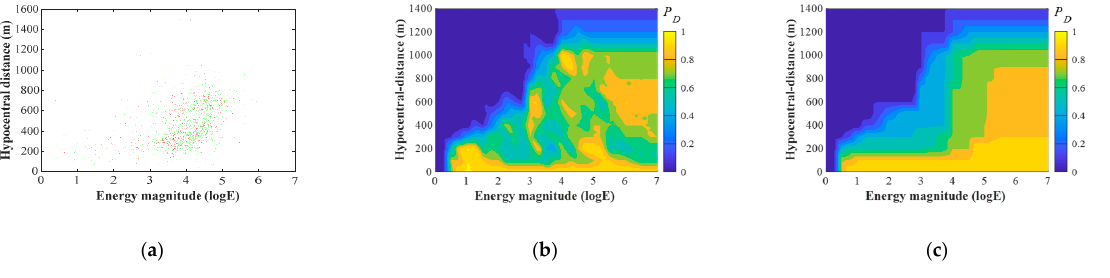
Figure 1. Examples of ( a ) a distribution of picked (green dots) and unpicked (red dots) seismic events of a geophone in the D-M map, ( b ) P D result of a geophone before applying constraints, and ( c ) P D result of a geophone after applying constraints [22].